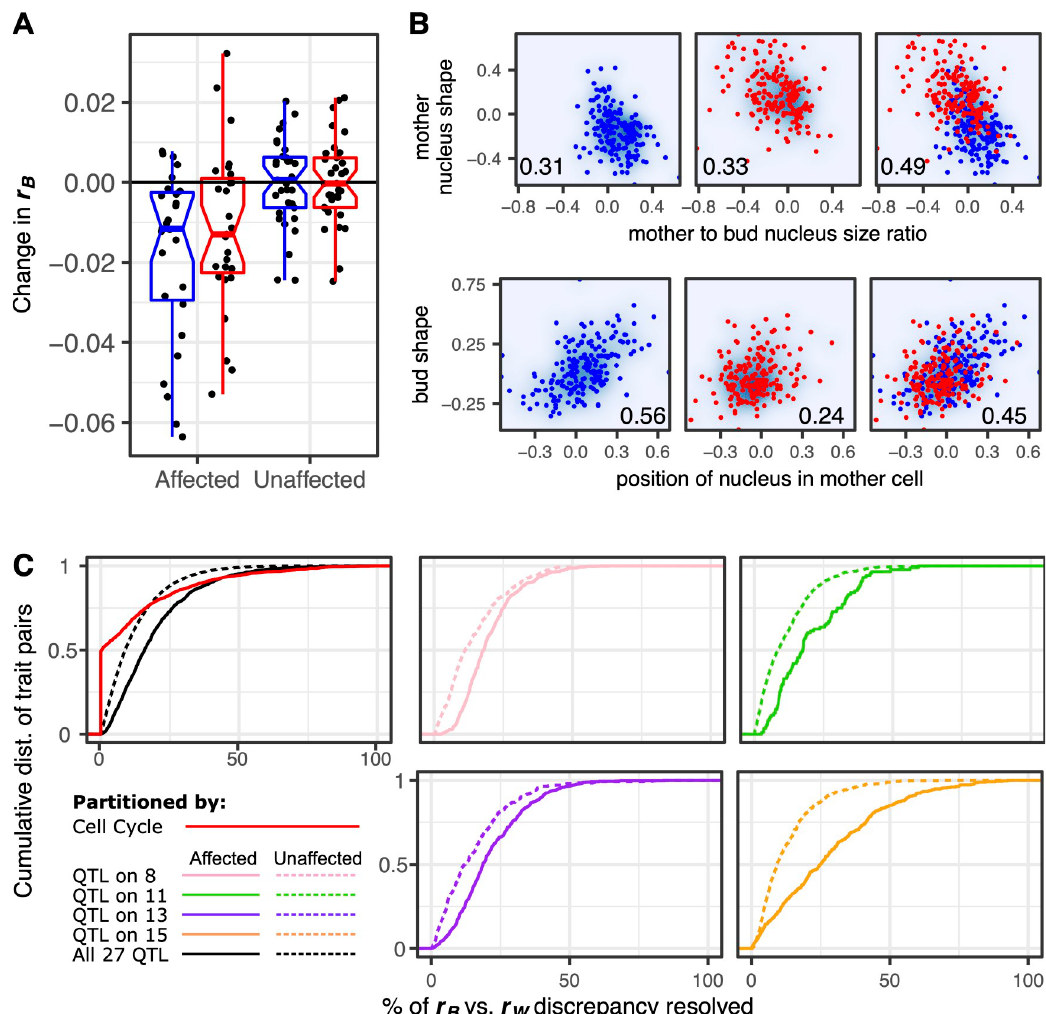
Fig 5. Many QTL demonstrate horizontal pleiotropy. (A) Eliminating allelic variation at the site of each QTL tends to reduce r B . The vertical axis represents how r B changes upon eliminating allelic variation at each QTL site. Each point represents the median change in r B for all pairs of traits that are affected or unaffected by one of the 27 QTL suspected of horizontal pleiotropy. Box plots summarize these changes in r B when remeasured across strains possessing the wine (red) or the oak (blue) allele at the marker closest to the QTL. (B) The upper and lower series of three plots demonstrate two different ways that a QTL can increase the correlation between traits. Each point represents a yeast strain possessing either the wine (red) or the oak (blue) allele at a marker closest to a QTL on chromosome 15 (upper) or 8 (lower). In the upper plots, the QTL increases the correlation between nucleus shape and size ratio when it is segregating across strains. In the lower plots, the oak allele strengthens a correlation between bud shape and the position of the nucleus in the mother cell that is weak in the wine subpopulation. Numbers in the lower corner of each plot represent r B for the strains displayed. (C) Cumulative distributions (“dist.”) display the extent to which binning cells or splitting strains resolves the difference between r B and r W . When calculating percent resolved (horizontal axes), we always plot the value in whichever subset (e.g., wine or oak) this percent is greatest. If subsetting always worsens the discrepancy between r B versus r W , we score this as 0% resolution. Only pairs of traits for which r B is significantly greater than r W are considered. The pink, green, purple, and orange lines show the effect of splitting strains by whether they inherited the wine or oak allele at the marker closest to each of four QTL (colors correspond to QTL in Fig 1A). In these plots, comparing the solid versus dotted lines shows that splitting strains resolves the discrepancy between r B and r W more often for pairs in which both traits are affected by the QTL than pairs in which both traits are unaffected. The black lines in the leftmost plot summarize these effects across 27 QTL, displaying for each trait pair the largest resolution in the r B versus r W discrepancy observed across all QTL that affect the pair of traits (solid line) or all QTL that do not (dotted line). The red line shows the effect of binning cells by their progress through division, displaying the largest resolution in the r B versus r W difference across all 16 bins. Data underlying this figure can be found at https://osf.io/b7ny5/. QTL, quantitative trait